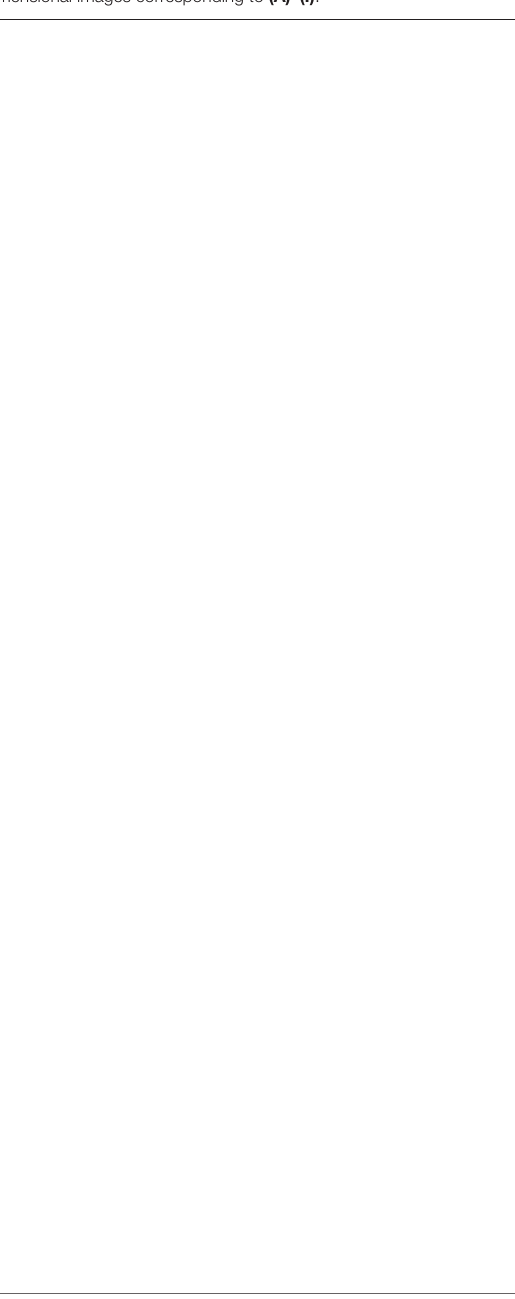
FIGURE 1 | or red. (A) Images of a DAPI-stained wild-type cell before and after 3D deconvolution in the Z-axis. (B–F) Fixed cells expressing GFP uv4 -fused proteins or GFP uv4 protein (not fused with any protein) were immunostained using an anti-GFP monoclonal antibody. Fluorescence images of the proteins were analyzed with 3D deconvolution at 0.5- µ m intervals in the Z-axis. Images of DAPI-stained nucleoids were also analyzed with 3D deconvolution. The yellow arrowheads indicate the clustered localization of protein molecules. (B) SecA-GFP uv4 , (C) SecY-GFP uv4 , (D) AcpP-GFP uv4 , (E) GFP uv4 (not fused with any protein), (F) No GFP uv4 . (G–I) Deconvoluted images of native proteins. Wild-type cells (PA340) were grown in medium L at 37 ◦ C, fixed, and immunostained using rabbit antisera for native proteins. Images of DAPI-stained nucleoids were also deconvoluted. (G) Native SecA, (H) Native SecY, (I) Native AcpP, (J) Three-dimensional deconvolution images of immunostained cells in wider sights corresponding to (B) – (I) . (A’–I’) Three-dimensional images corresponding to (A) – (I)